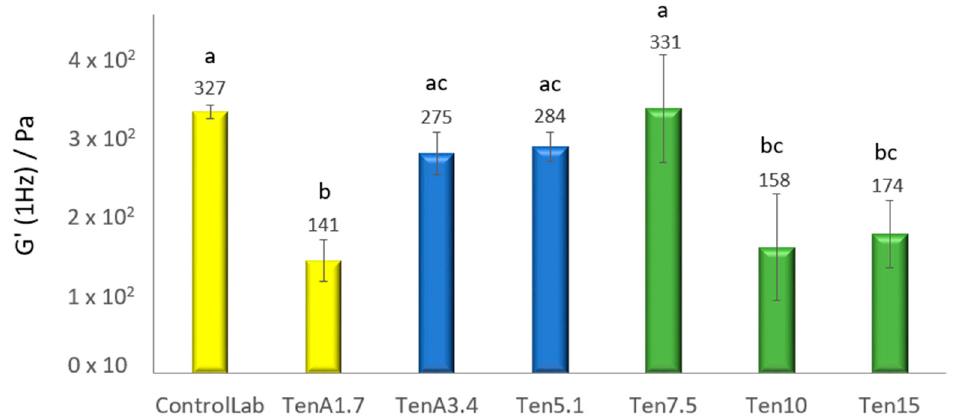
Figure 3. G’(1 Hz) of the emulsions (ControlLab, TenA1.7, TenA3.4, Ten5.1, Ten7.5, Ten10 and Ten15). The different lowercase letters (a, b and c) located above each bar represent the significant difference between formulations ( p < 0.05), according to the ANOVA calculation.